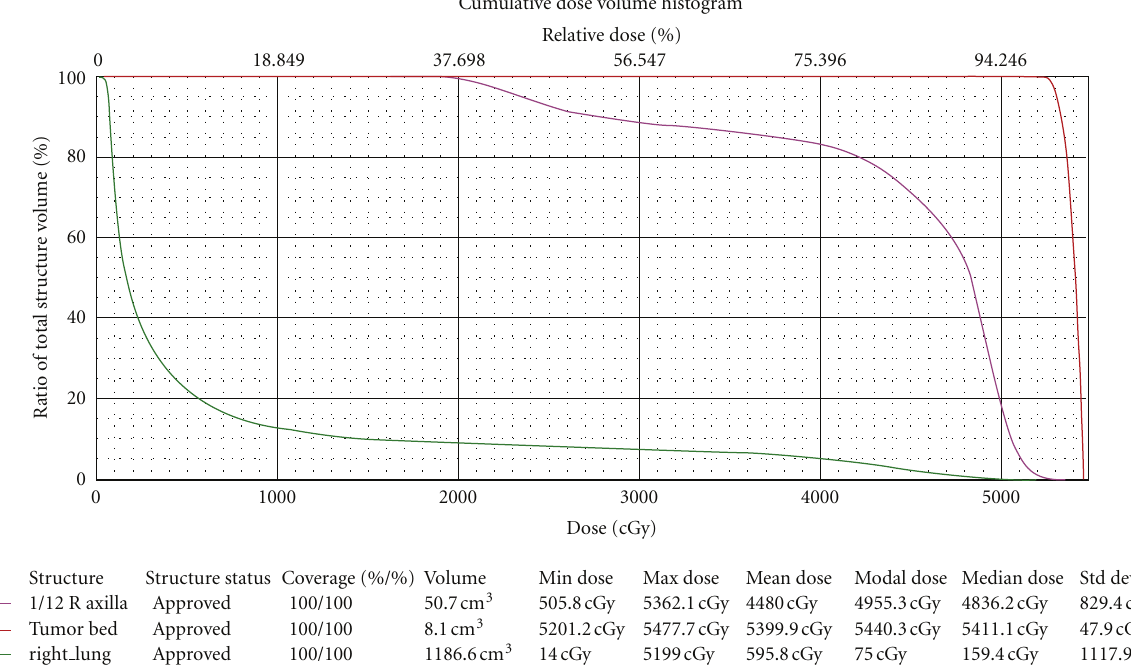
Figure 4: Dose volume histogram showing coverage of breast tumor bed (red) with standard breast tangents and incidental ipsilateral axillary coverage